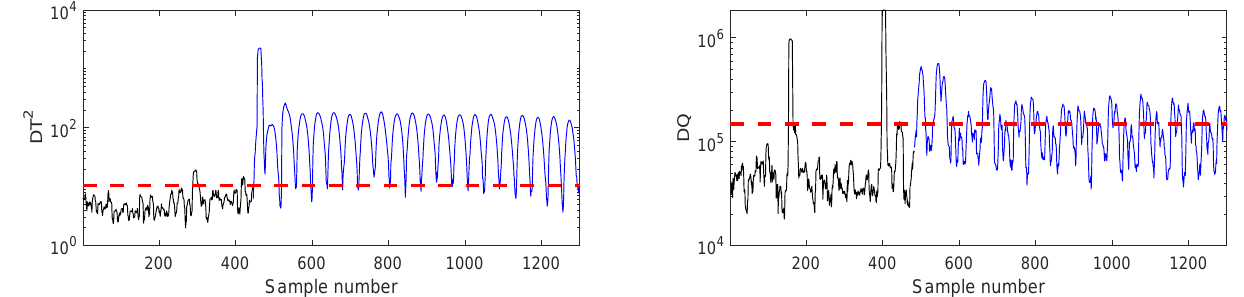
Figure 5. CVA k NN monitoring results on the DATA-2 case.